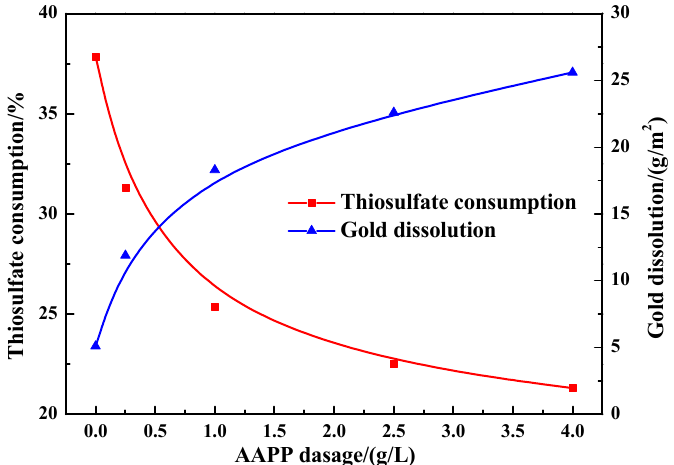
Figure 8. Effect of AAPP on thiosulfate consumption and gold dissolution in thiosulfate leaching of gold in the presence of 10 g/L pyrite.